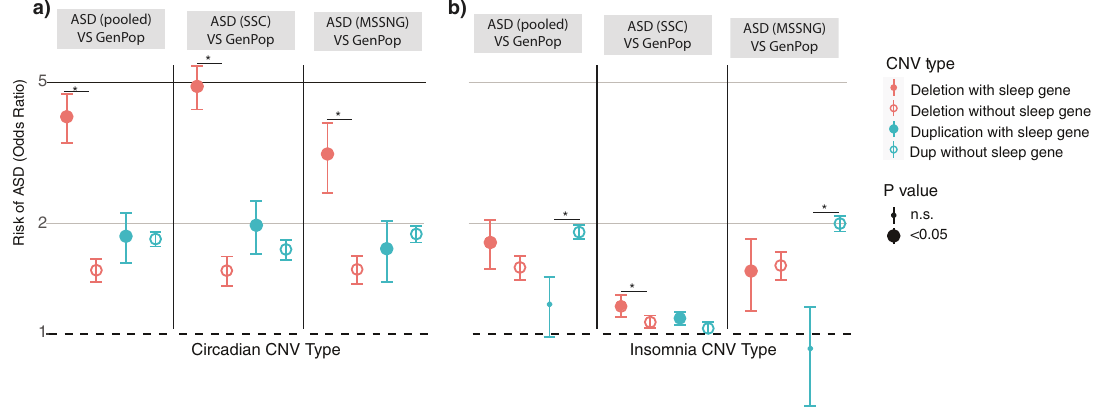
Fig. 3 Associations between ASD and sleep risk genes. a Associations between ASD risk and CNVs encompassing circadian pathway genes. b Associations between ASD risk and CNVs encompassing insomnia risk genes. *Indicates bootstrap analyses show no overlapping 95%